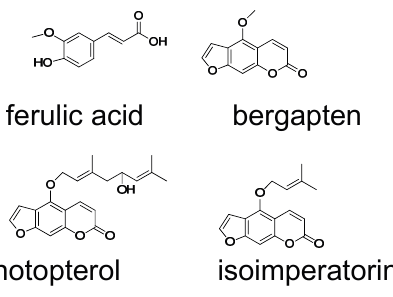
Figure 6. Chemical structures of the standard